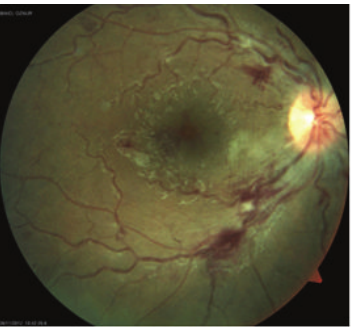
Figure 5: Fundus photograph of the right eye two weeks after the initial examination.